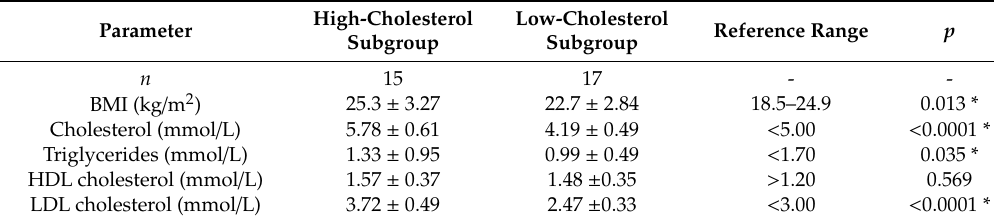
Table 3. Comparison of lipid profile in high- and low-cholesterol